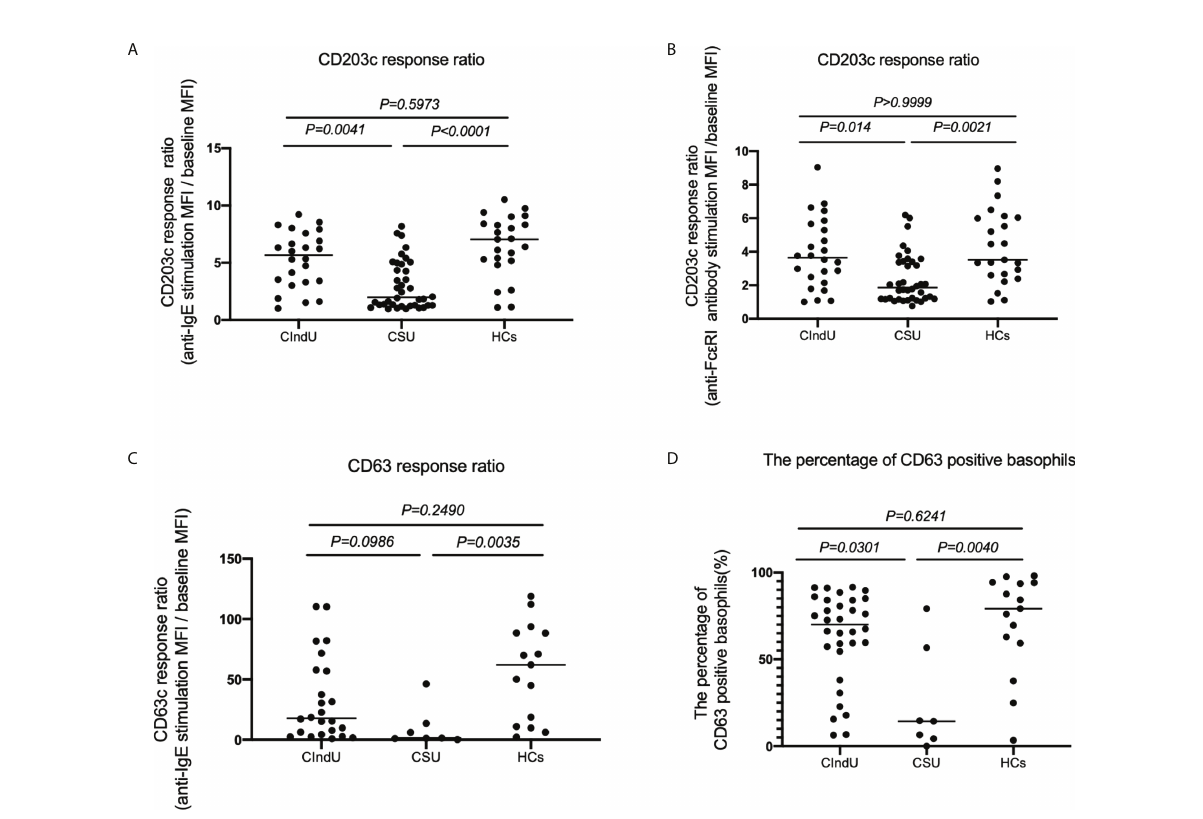
FIGURE 2 CD203c response ratio, CD63 response ratio and the percentage of CD63 positive basophils. CD203c response ratio of basophils when stimulated with (A) anti-IgE or (B) anti-Fc ϵ RI antibody. (C) CD63 response ratio of basophils when stimulated with anti-IgE, and (D) the percentage of CD63 positive basophils when stimulated with anti-IgE. Statistical analysis was carried out using the Kruskal-Wallis test with Dunn ’ s multiple comparisons